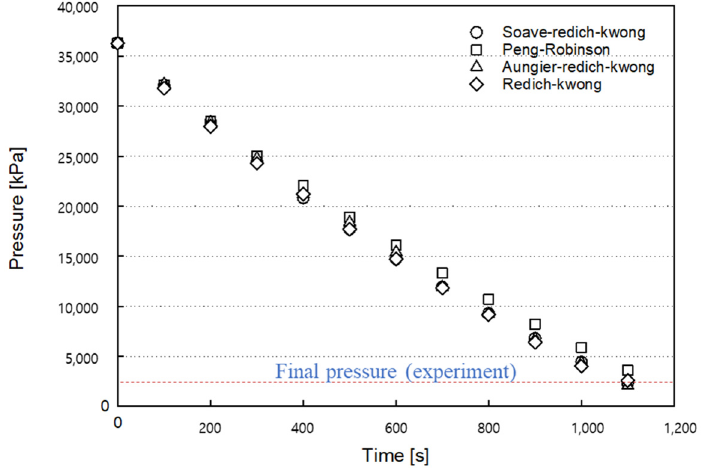
Figure 3. Averaged pressure of the inner gas tank for the different gas models and experimental results for the hydrogen discharge case.